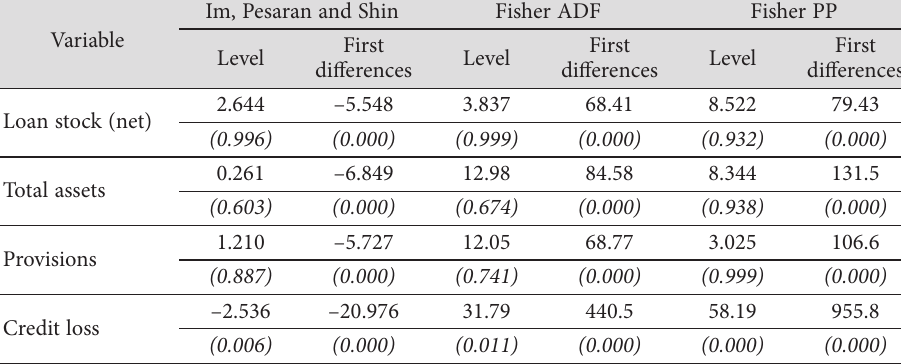
Table 7. Panel unit root tests (bank-specific variables)